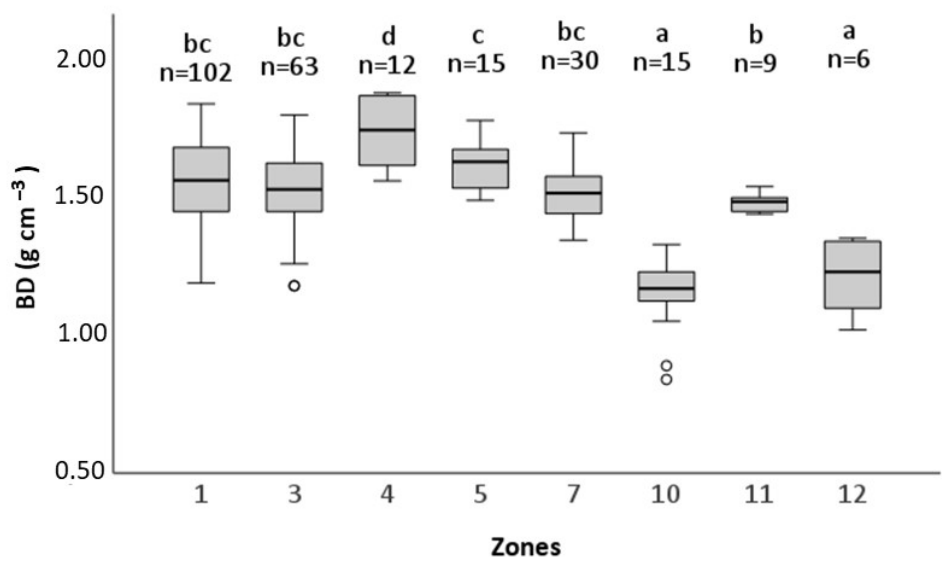
Figure 2. Bulk density (BD) in conventionally managed topsoils (0–30 cm) in each of the zones selected for this study. Center lines show the medians, box limits indicate the 25th and 75th percentiles, whiskers extend 1.5 times the interquartile range from the 25th and 75th percentiles, outliers are represented by dots. Values marked with different letters are significantly different ( p < 0.05) according to ANOVA. Values showing the same letter belong to the same homogeneous group according to Duncan’s test. Open circles are outliers.